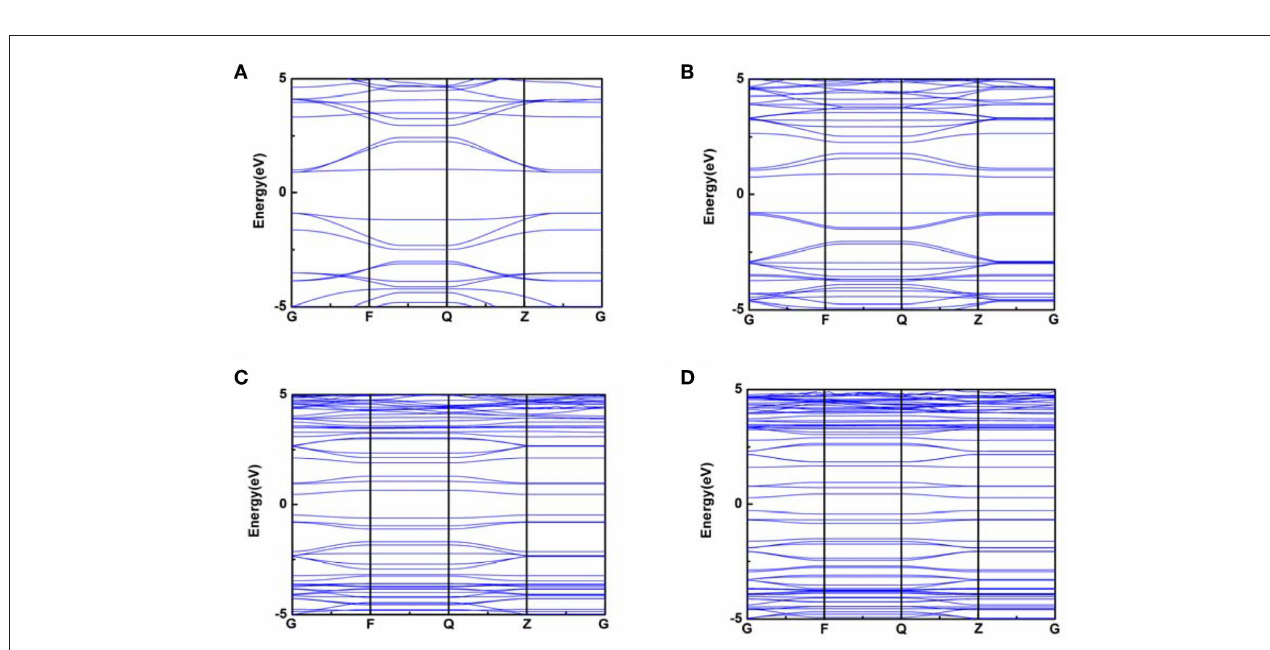
phenyl rings in two-dimensional closed conjugated molecular structure, and the electron fluidity became better at the same